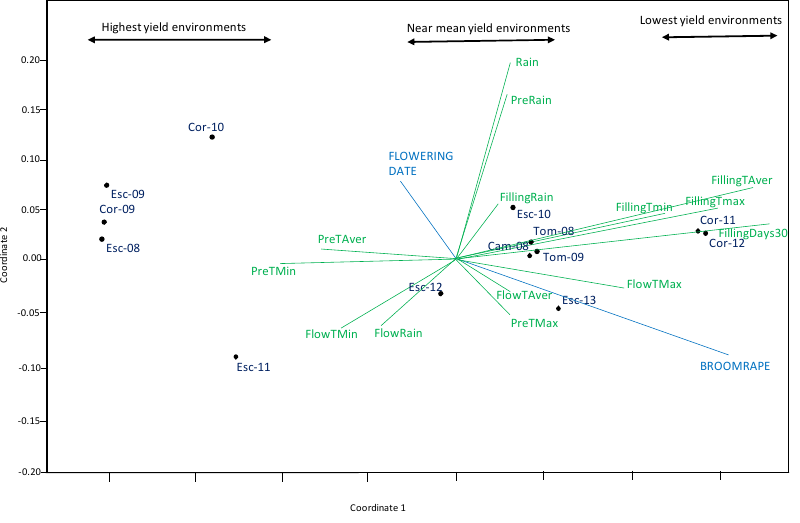
Figure 5. NMDS combined analysis of climate variables including: maximum temperature (T max ), minimum temperature (T min ) and rain during different growing stages [pre-flowering (Pre), flowering (Flow), grain filling (Filling)], and number of days with T max > 30 °C at grain filling and traits assessed on grain yield.